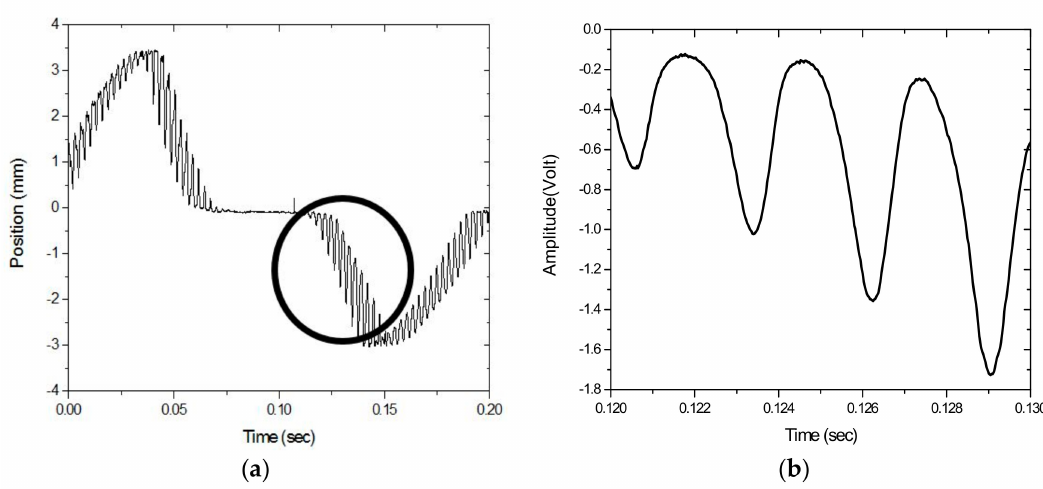
Figure 10. ( a ) PSD-detected signal and ( b ) the enlarged portion of the motion of the vibrating string at 3.9 × 10 − 2